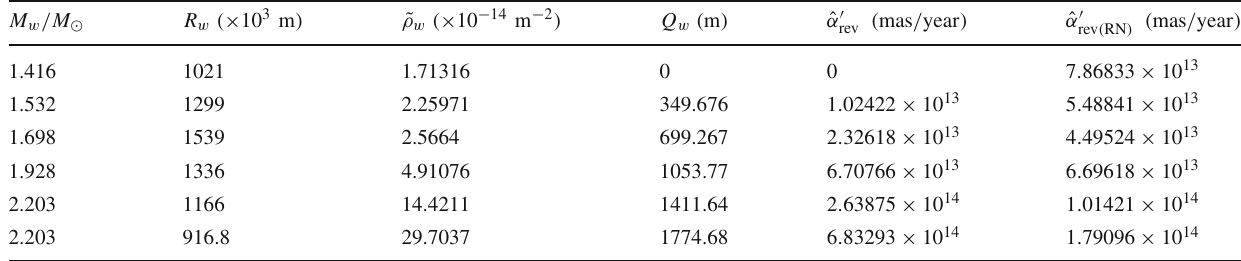
have let L = 10 − 7 . 6 m, and the radius of orbits for the gyroscopes in the RN geometry has been put r g = R w + r h for each of the cases